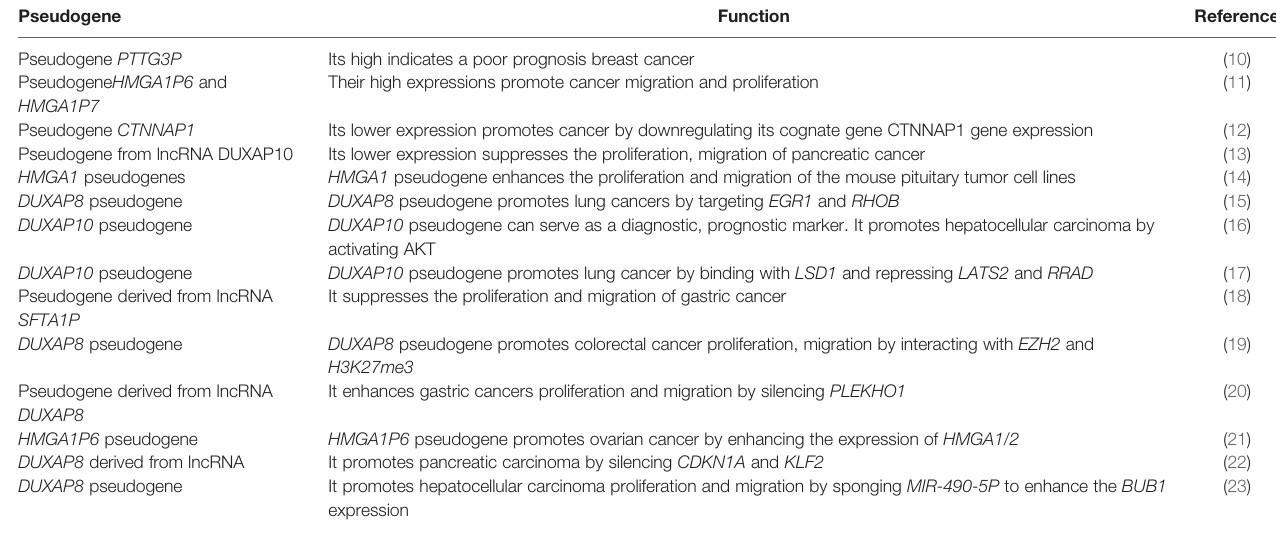
TABLE 1 | Functions of pseudogenes in different